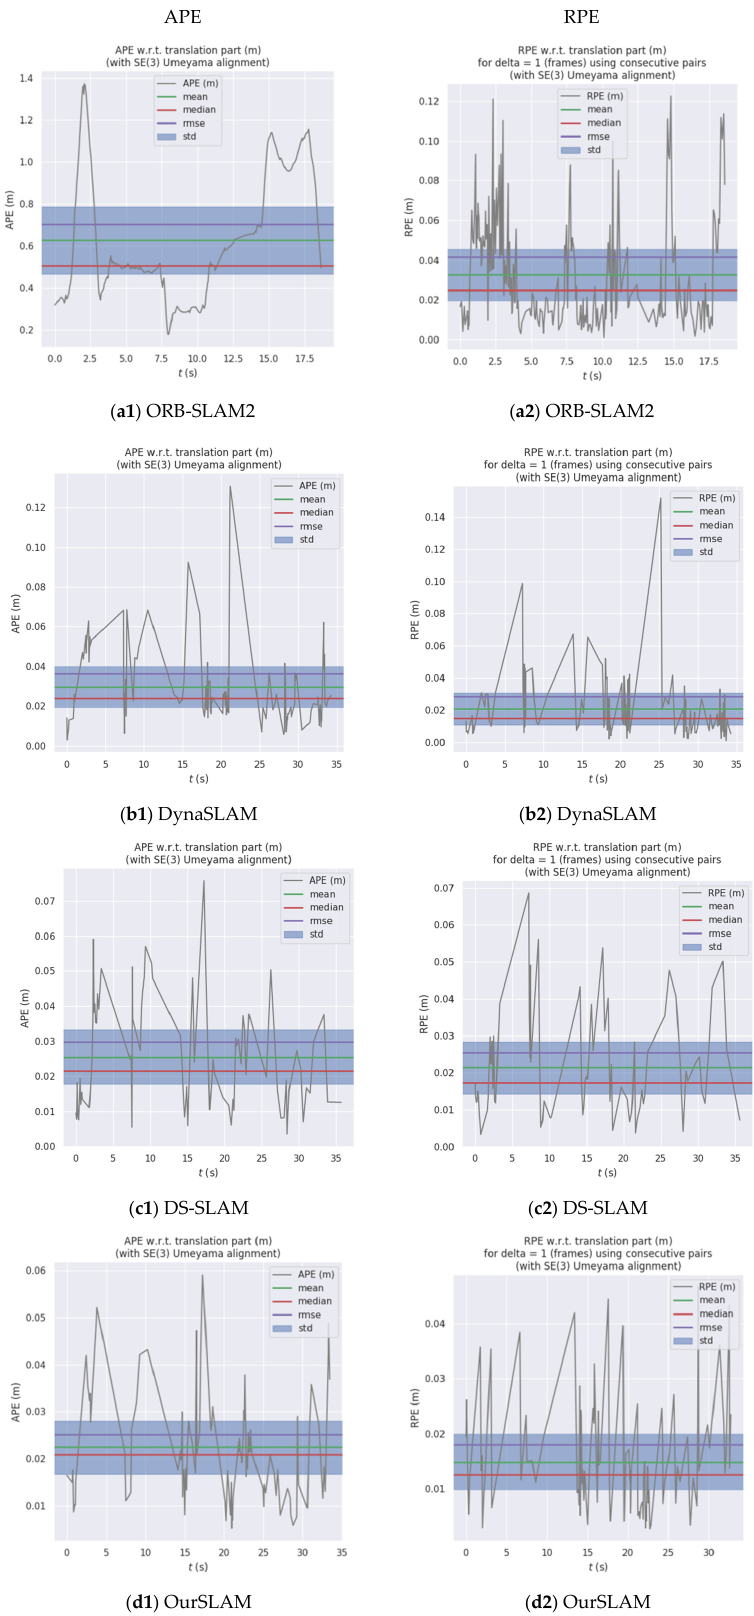
Figure 11. APE, RPE results for ORB-SLAM2, DynaSLAM, DS-SLAM, and OurSLAM on dataset fre3_walking_halfsphere. The results of the experiments performed on the fr3_walking_halfsphere dataset are shown in Figure 12. On both APE and RPE, the error trajectories of ORB-SLAM2 and DynaSLAM have obvious red trajectories, so these two algorithms have some errors in performing trajectory prediction. Compared with ORB-SLAM2 and DynaSLAM, a small amount of red traces exist on the error trajectories of the DS-SLAM algorithm, which in- dicates that DS-SLAM has less error in performing trajectory prediction, and thus that its